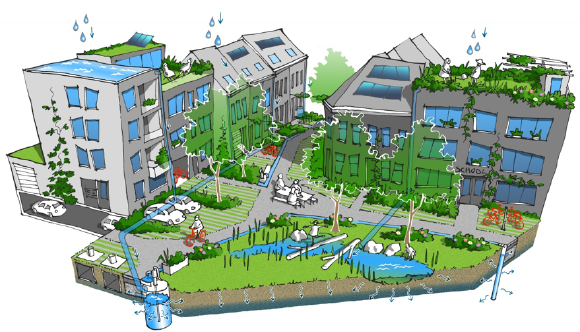
Figure 2. The city of Antwerp plans to construct garden streets to fight problems caused by climate